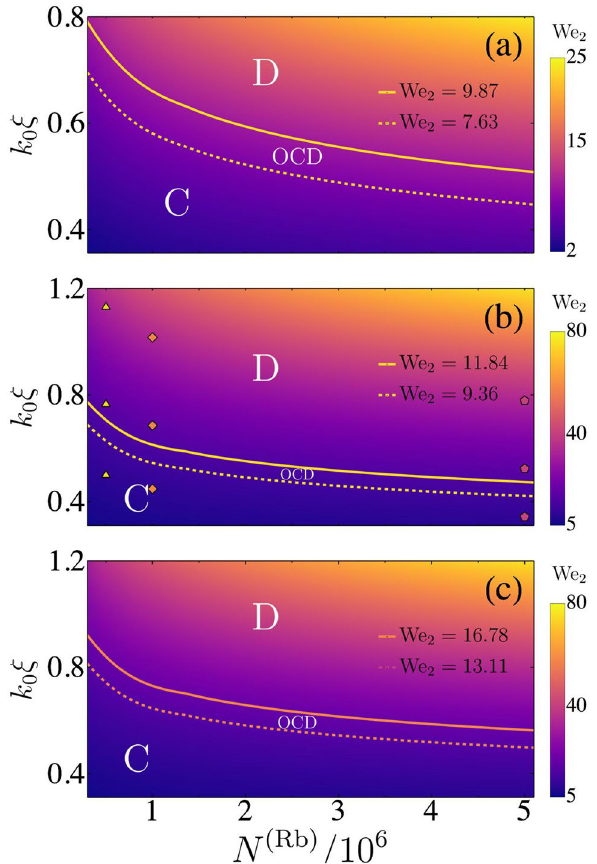
Figure 6. Quadrupole Weber number We 2 as a function of the number of atoms of a given species is illustrated for ( a ) homunuclear and ( b ) hetero-nuclear droplets ( c ) hetero-nucleat droplets including atom losses. In the first case N corresponds to half the total number of atoms in the droplet and in case ( b ), ( c ) to N ( Rb )